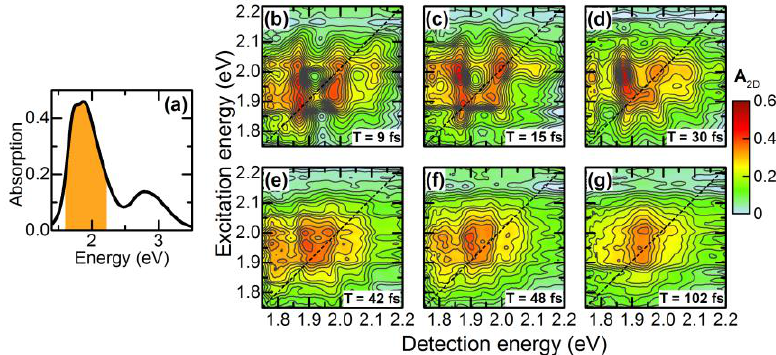
Fig. 1. Two-dimensional electronic spectroscopy (2DES) of the A-D-A oligomer thin film. (a) Linear absorption spectrum of the thin film. The excitation range is highlighted in yellow. (b-g) Absorptive 2DES maps at selected waiting times T.